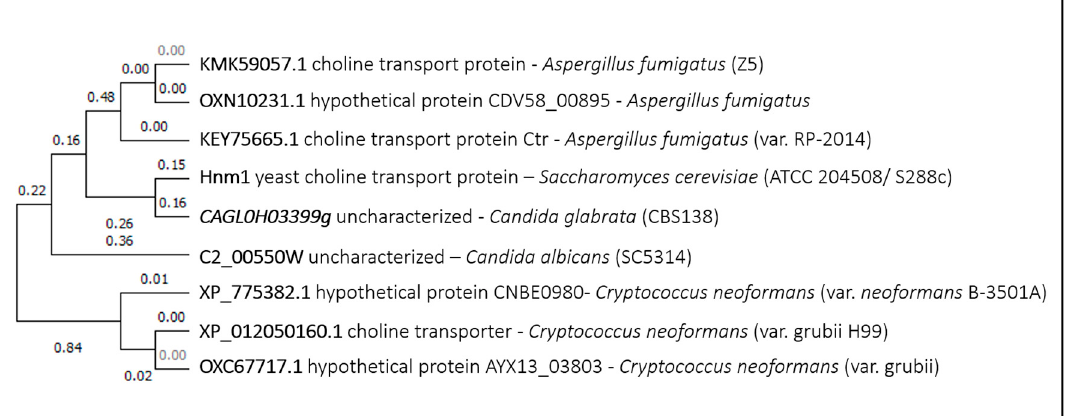
Figure 6. Hnm1 phylogenetic analysis. The tree with the highest log likelihood is shown. This analysis involved nine amino acid sequences. There were a total of 686 positions in the final dataset. Evolutionary analyses were conducted in MEGA X.